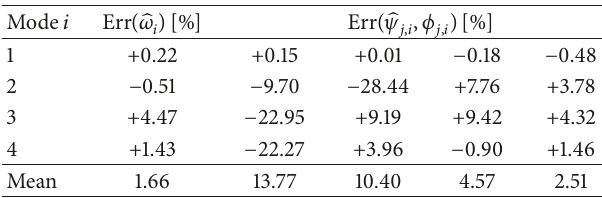
Table 3: Percentage errors on estimated values (normalized to unitary masses). Mean errors are computed on the absolute values of above